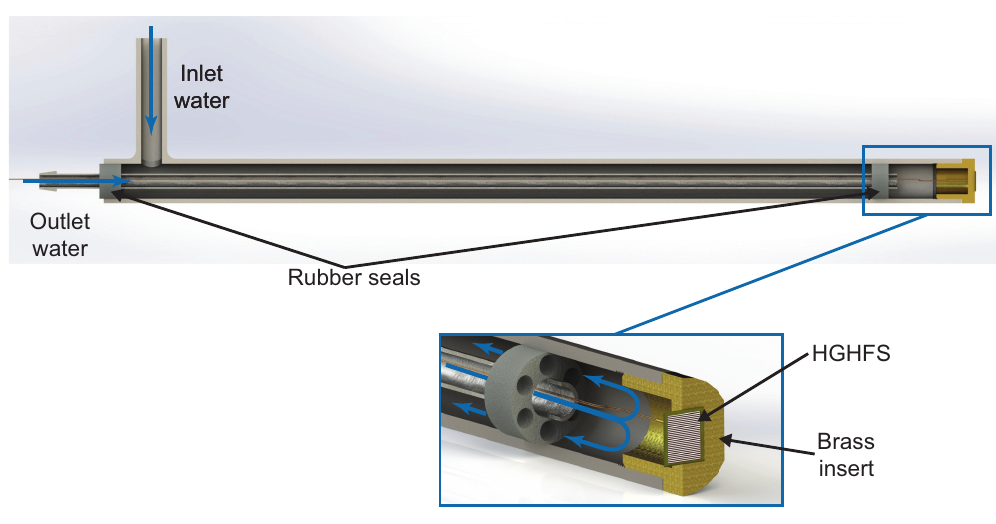
Figure 4. Experimental probe